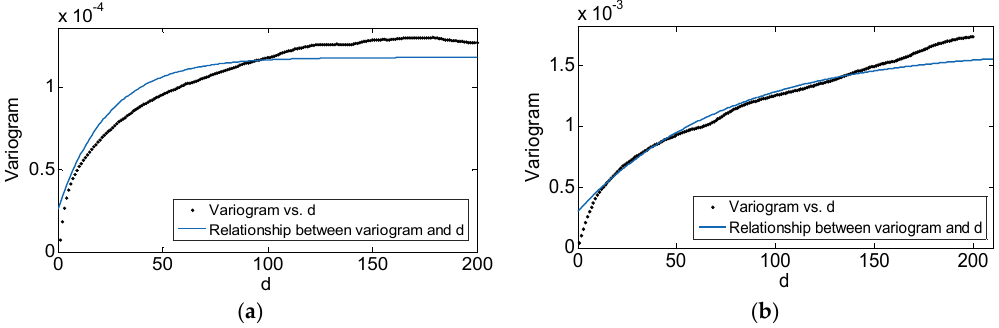
Figure 8. Relationship between the variogram and d . ( a ) The acquisition date of the MODIS image is 10 February 2015. ( b ) The acquisition date of the MODIS image is 14 February 2015. The black dots are actual calculated variogram values and the blue solid lines are the curve fittings. Table 5. Results of the variogram curve fitting for the Beijing–Tianjin–Hebei regions. The R-square denotes the coefficient of fitting determination.